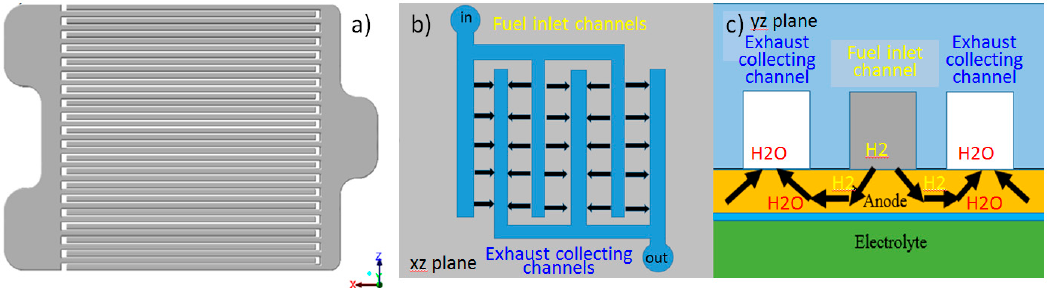
Figure 2. ( a ) Interdigitated design for the fuel flow rib channels; ( b ) The schematic diagram of the interdigitated design in the y-direction view; ( c ) Species transports among the fuel inlet channels, exhaust collecting channels, and the porous anode.